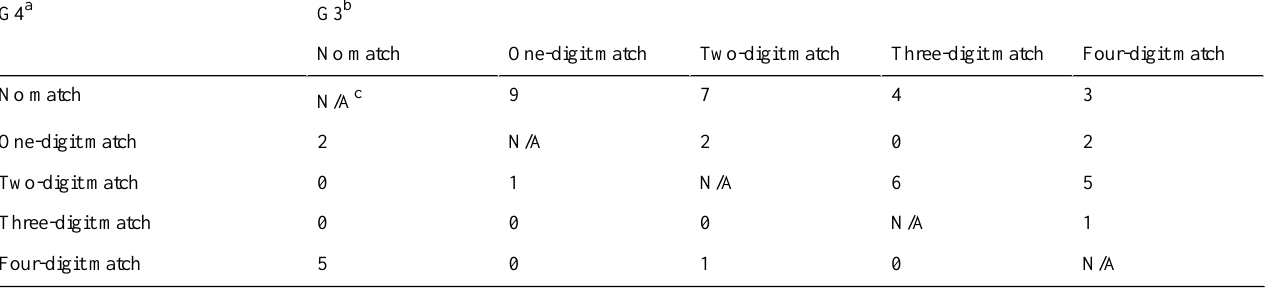
Table 11. Performance of Generation 4 compared with Generation